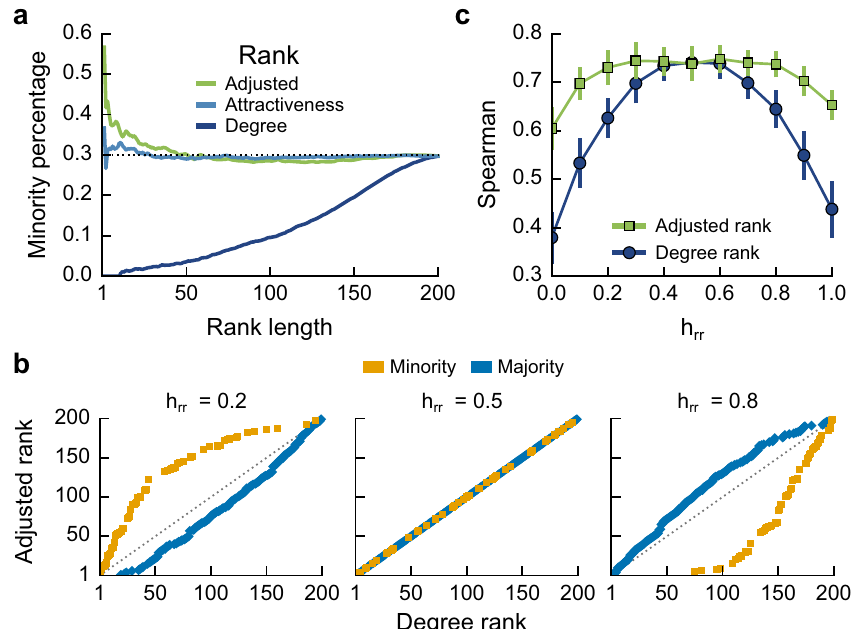
Fig. 5 Adjusting for group mixing decreases misrepresentation in degree rankings. a The percentage of minority members in rankings of increasing lengths. Each curve represents a different type of ranking regarding a system with minority fraction f 0 = 0.3 and at a symmetrical homophilic mixing h = 0.8. In this case, degree rankings underrepresent minority members; at heterophilic regimes, minority members are overrepresented (see rr Supplementary Note 8). The adjusted ranking decreases this misrepresentation by accounting for individuals' group membership. b The adjusted ranking versus the degree ranking at different regimes. As expected, heterophily promotes minority members to higher positions in the degree ranking, whereas homophily pushes the minority down. In the plot, dashed lines represent the case of identical rankings. c The Spearman correlation between the intrinsic attractiveness and the adjusted and degree ranking. The adjusted ranking tends to agree with the intrinsic attractiveness except in the extreme cases of h rr = 0 and h rr = 1. In the plot, the bars represent one standard